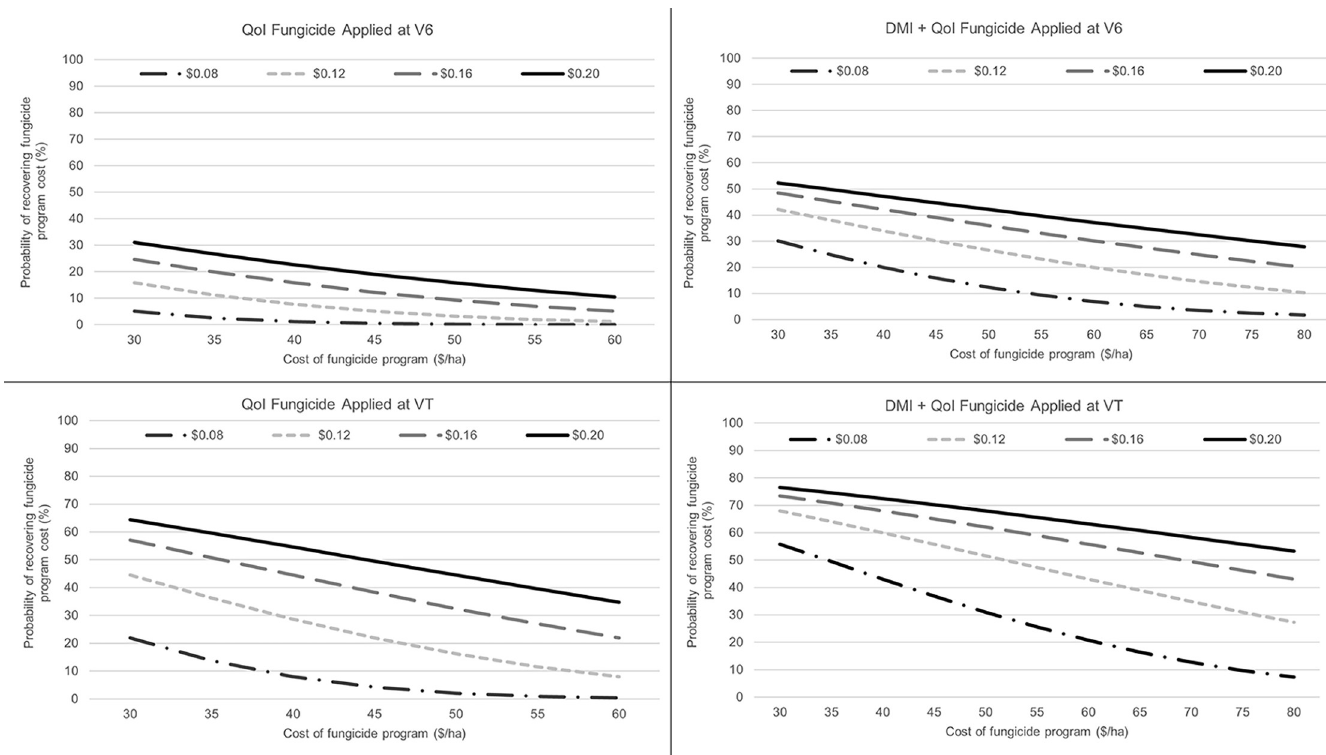
Fig 2. Probability of recovering fungicide cost for a range of corn market prices in $/kg, and fungicide costs estimated for two fungicide classes, quinone outside inhibitors (QoI) and demethylation inhibitors (DMI) + QoI, applied at V6 (six leaf collar growth stage) or VT (tasseling growth stage of corn), based on estimated yield differences and between-study variances from